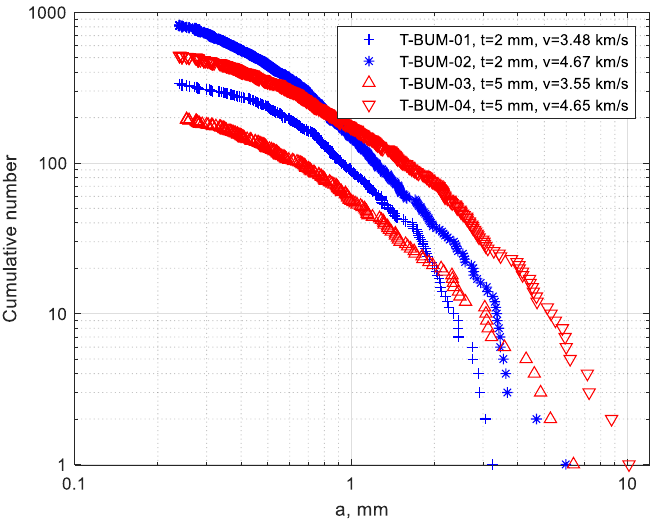
Figure 7. Fragments cumulative size distributions for the four aluminum thin plates tests [45].